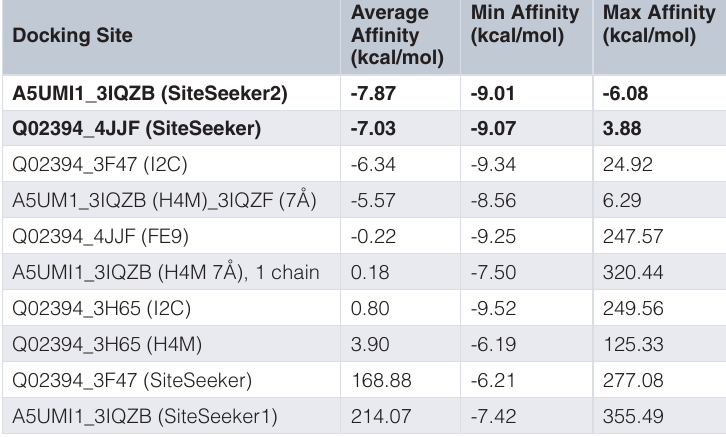
Table 2. Average, minimum, and maximum affinity for each site. Affinities were computed from AutoDock Vina 26 . The top two scoring sites from A5UMI1 and Q02394 are in bold. These sites were used to rank the ligands in Table